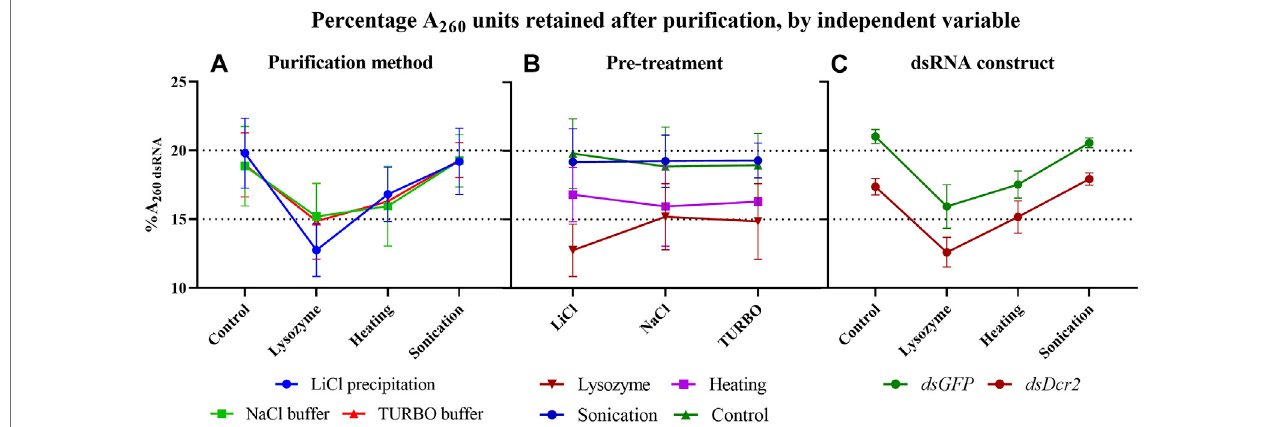
FIGURE 3 | In these graphs, the data of Table 1 are plotted to highlight the impact of the three independent variables (puri fi cation method, pre-treatment, and dsRNA construct) on the percentage of A 260 units retained following dsRNA puri fi cation (%A 260 dsRNA ). When the data are sorted on the y-axis by one variable (pre- treatment for panel (A,C) , or puri fi cation method for panel (B) and pooled as replicates by a second variable (dsRNA construct for panel A and B, or puri fi cation method for panel (C) , the effect of the third variable can be visualized. Symbols indicate the mean, error bars the standard deviation. (A) : The puri fi cation methods have no signi fi cant impact ( p = 0.9945) on the %A 260 dsRNA . (B) : The pre-treatments have a major effect ( p = 0.0007) on the %A 260 dsRNA . (C) : The GFP construct results in a higher %A 260 dsRNA than the Dicer2 construct ( p < 0.0001). Statistical analysis performed with a repeated measure two-way ANOVA.